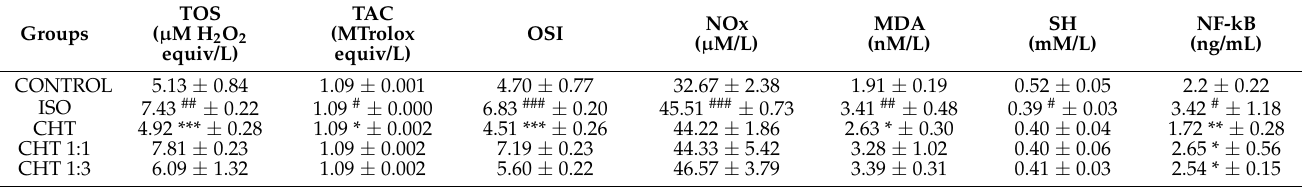
Table 5. Serum oxidative stress markers in rat isoprenaline-induced myocardial ischemia.